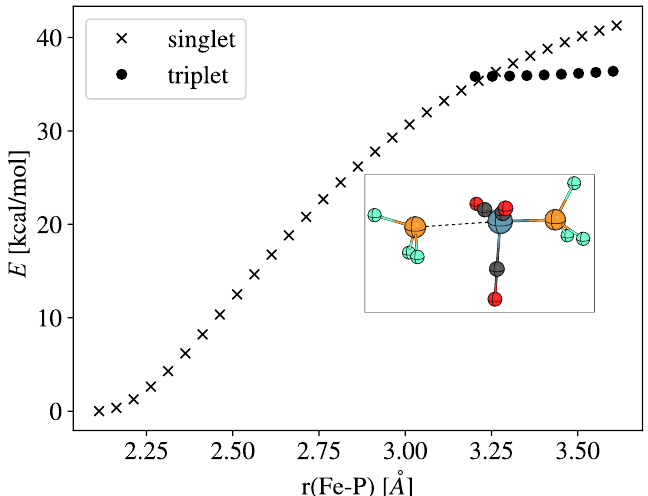
Figure 2. Energies of the partially optimized singlet and triplet Fe(CO) 3 (PF 3 ) 2 relative to the overall singlet minimum, at various Fe–P distances. The computed structure in the inlet represents the minimum energy crossing point